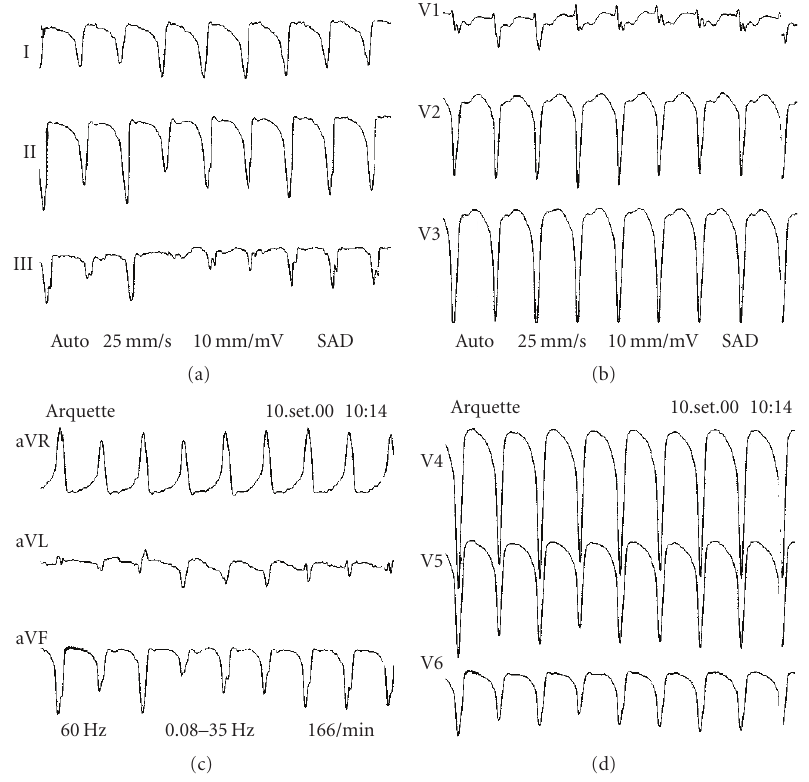
Figure 1: Ventricular tachycardia with left bundle branch block morphology and left axis deviation.